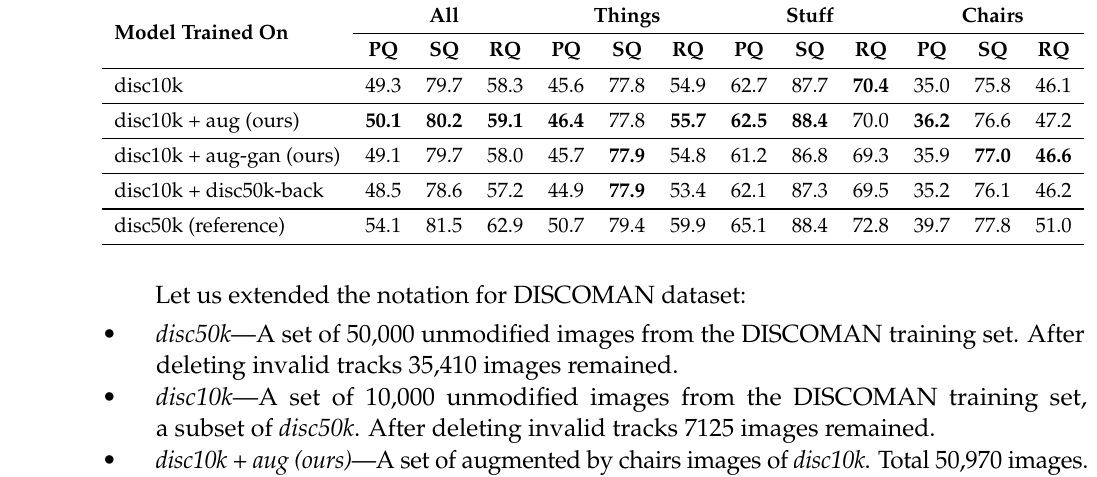
Table 7. Comparison of the panoptic segmentation methods trained on various original and post- processed combinations of DISCOMAN data. Numbers in bold indicate the best result in the column. All Things Stuff Chairs Model Trained On PQ SQ